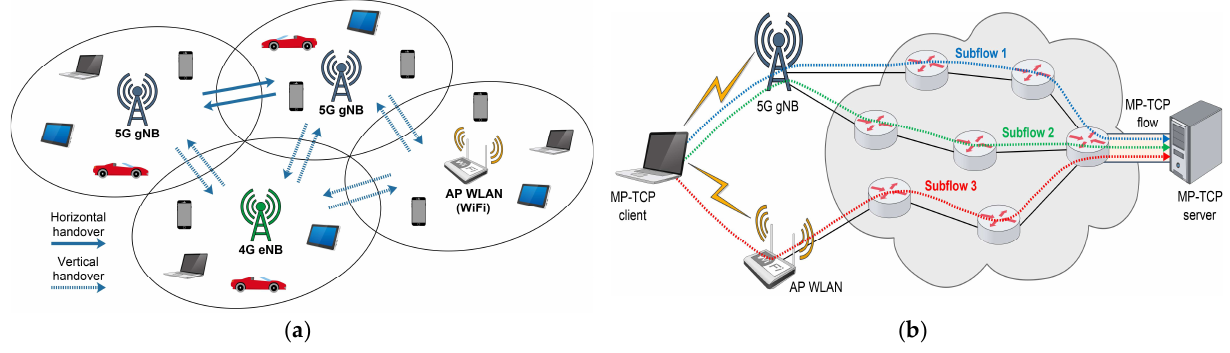
Figure 9. ( a ) Horizontal and vertical handovers, ( b ) Transfer of different MP-TCP subflows.